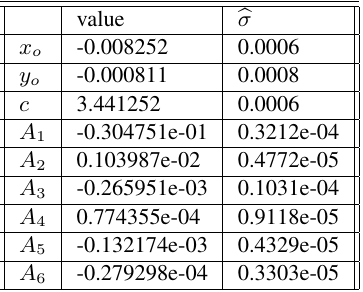
Table 5: Results of the interior orientation of test 2 with one cam- era model for all images (see sec. 3.2)